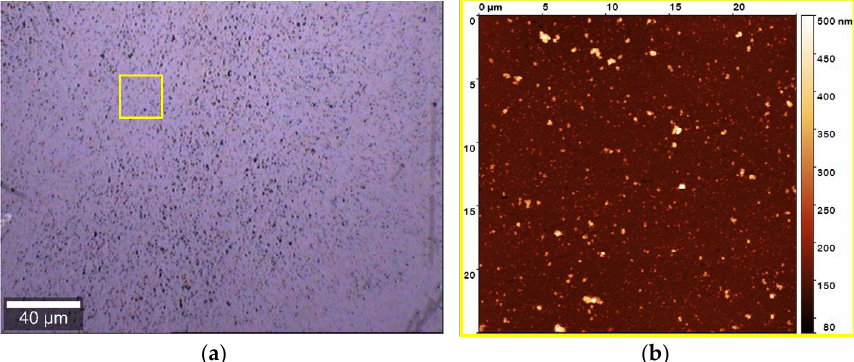
Figure 3. Atomic force microscopy (AFM) analysis of the polydopamine (PDA) film obtained in the presence of hexamethylenediamine (HMDA). ( a ) Bright-field image of the investigated sample region collected by 20× microscope objective. ( b ) AFM image of the area indicated by the yellow square in the optical image. Film thickness: 40 ± 15 nm.